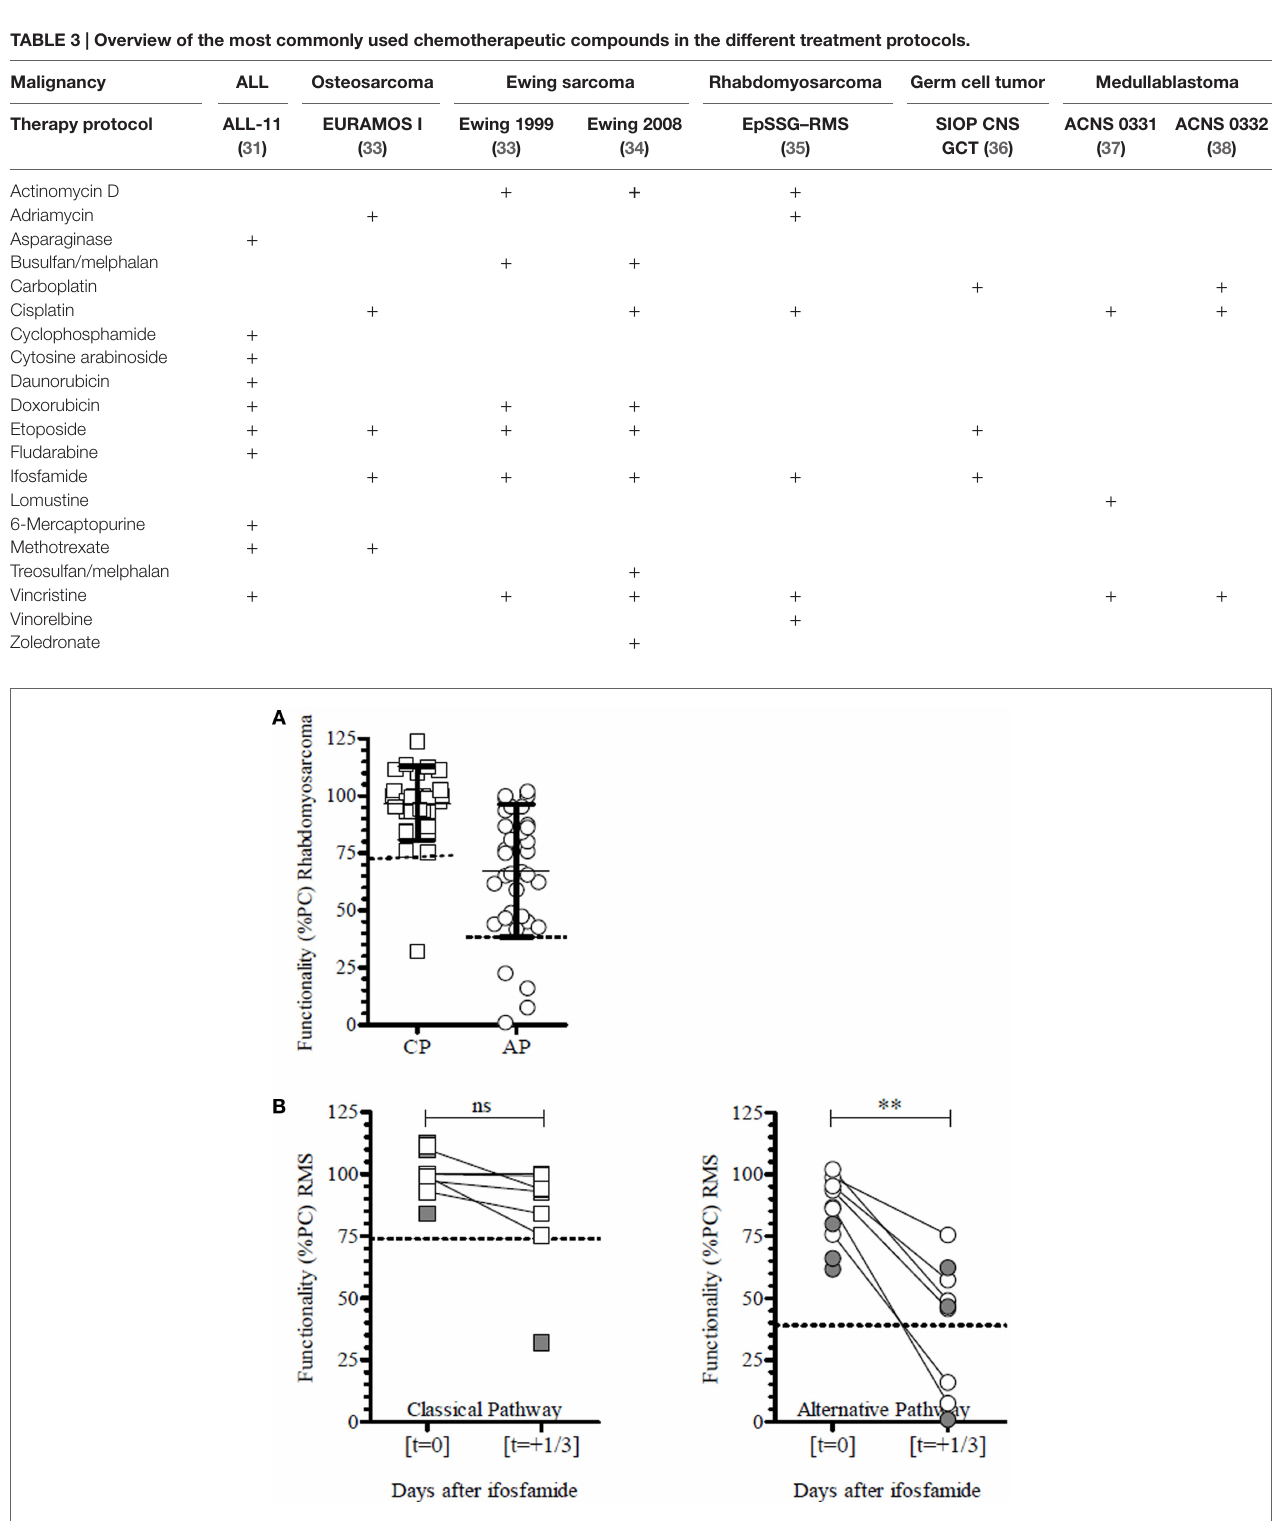
FigUre 7 | classical (cP) and alternative (aP) pathway complement functionality of patients with rhabdomyosarcoma (rMs) . (a) Functionality of the complement system of all patients ( n = 3) with rhabdomyosarcoma show no specific CP defects, whereas there are few specific AP defects ( n = 3) and a single combined defect. (B) Combined time points from all patients with rhabdomyosarcoma receiving ifosfamide. Although no reduced functionality was observed at all time points, the AP was significantly reduced following therapy, whereas the CP remained unaffected. Unpaired samples are depicted in gray. Dotted lines represent the lower cutoff of normal complement functionality. ** p < 0.01; paired t -test ( n = 7). Functionality is depicted as percentage of a positive control (%PC).